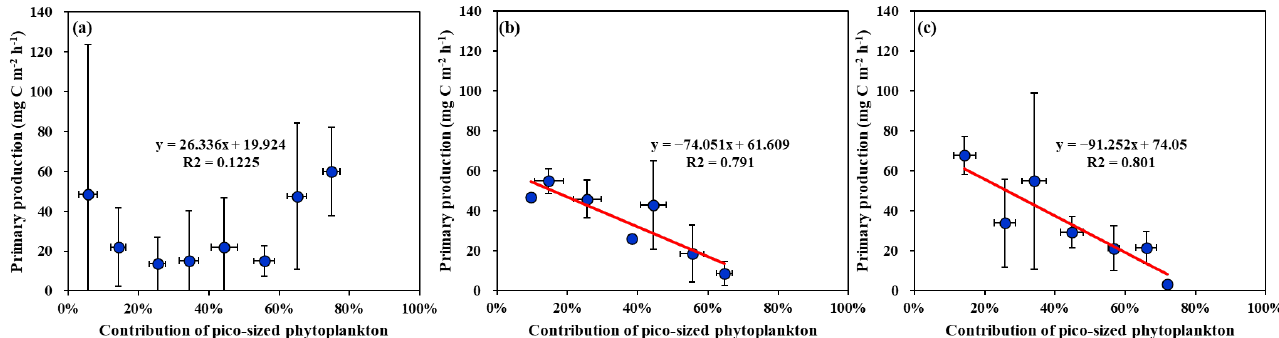
Figure 9. Relationships between primary production and contribution of pico-sized phytoplankton (<2 µ m) to total chl- a concentrations in the YS ( a ), the SS ( b ), and the EJS ( c ), 2018.